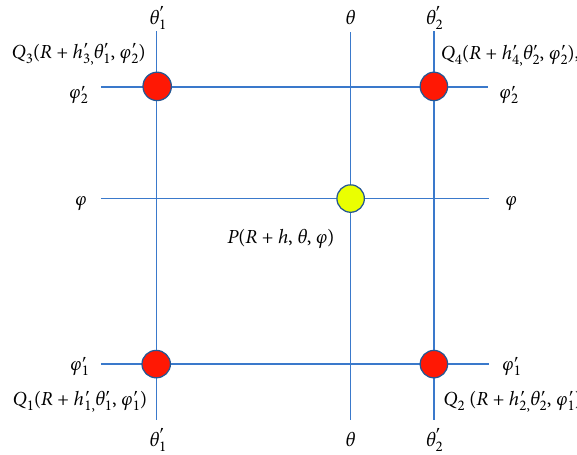
Figure 6: Schematic diagram of vertexes.